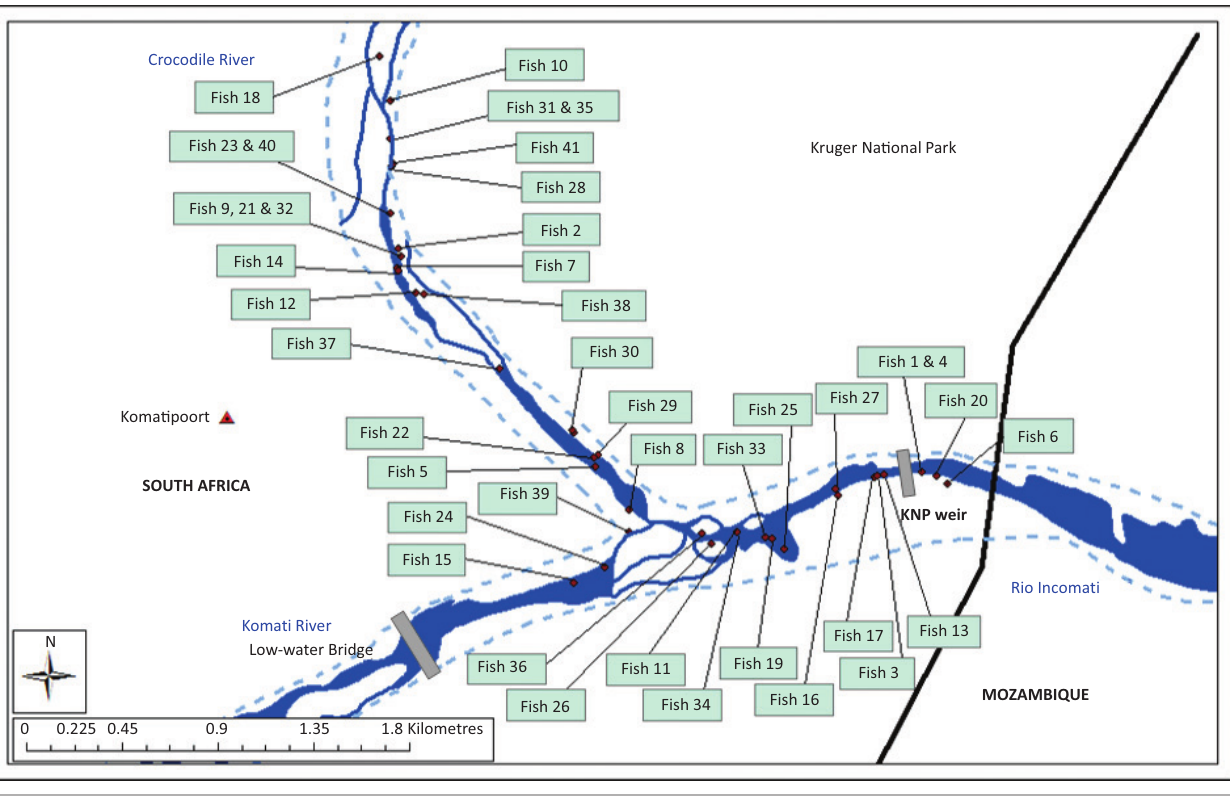
FIGURE 2: Map of the study area indicating tagging sites of all 41 radio-tagged fish.